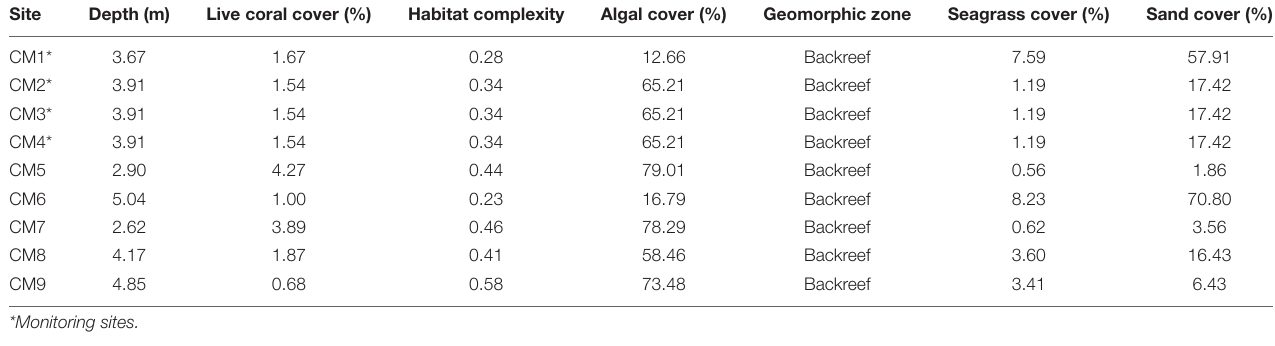
TABLE 1 | Locations and GAO values of the outplant sites selected.